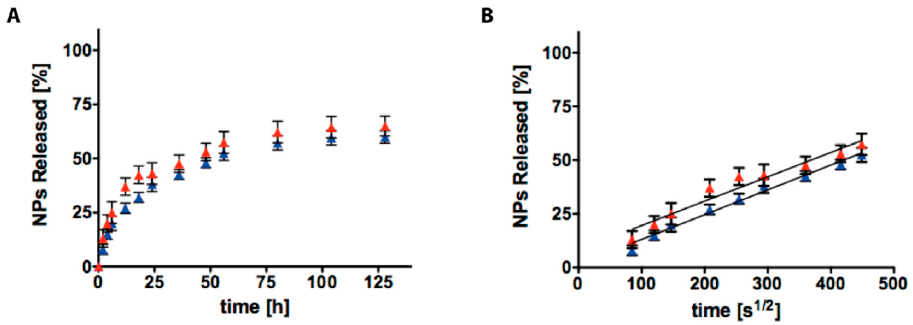
Figure 5. Cumulative release of NPs with different electric charges (negative, blue triangles and positive, red triangles) from AC1 hydrogel at pH = 5 ( A ); the slope of NPs released from AC1 hydrogel against the square root of time represents the role of NPs electric charges in mass transport at pH = 5 ( B ). The values are calculated as a percentage, with respect to the total mass loaded (mean value ± standard deviation is plotted).